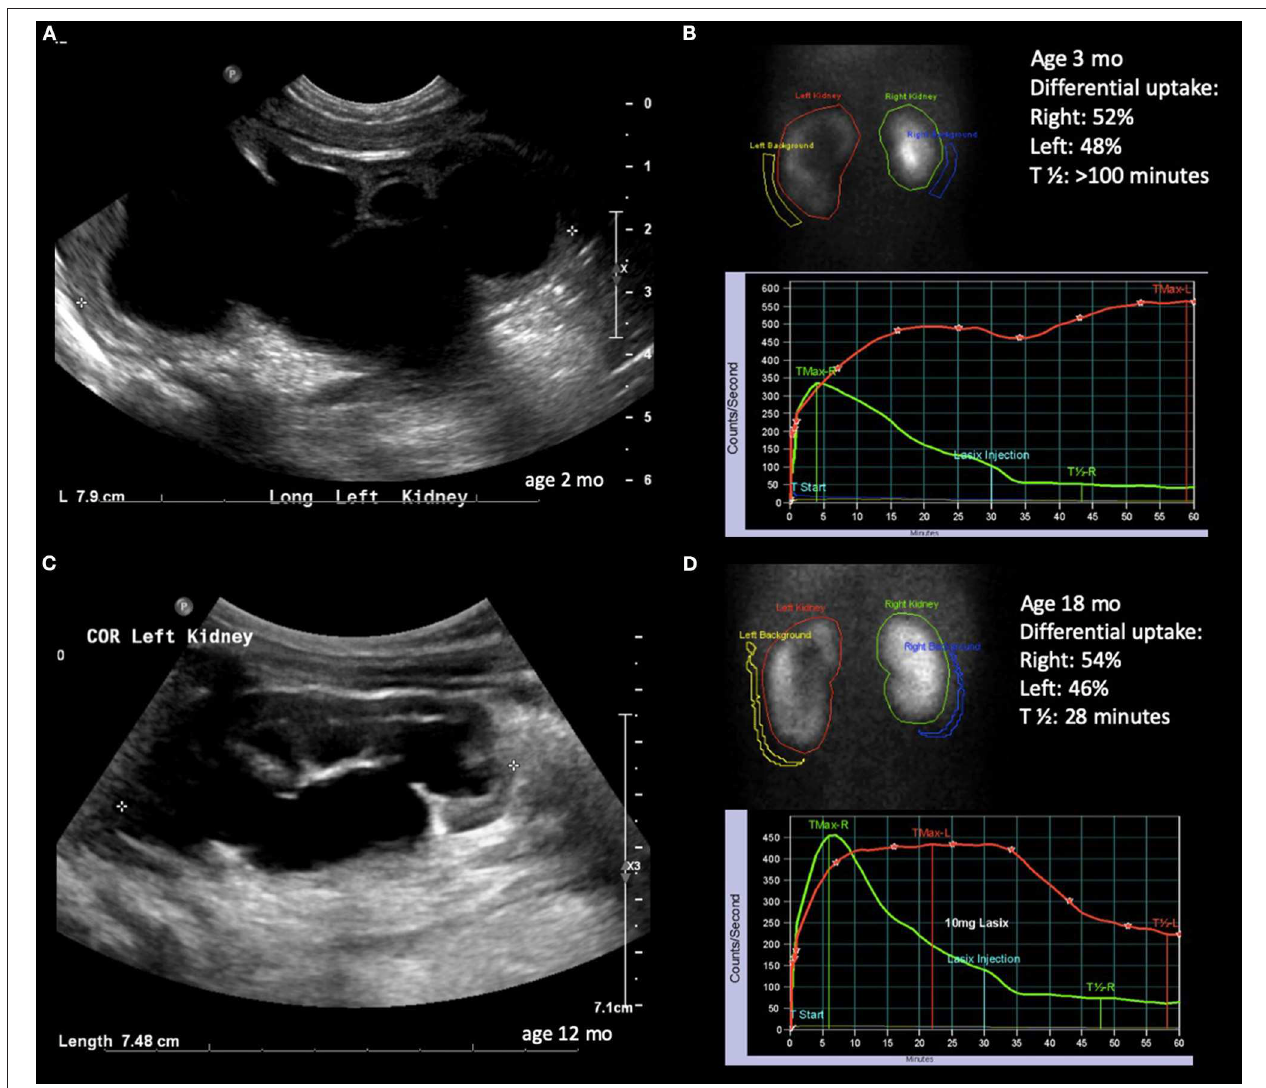
FIGURE 3 | Radiological history of an infant with severe hydronephrosis secondary to UPJ obstruction and biphasic diuretic curve. (A) Ultrasound confirming SFU grade 4 hydronephrosis at 2 months of age. (B) Diuretic renogram showing symmetrical uptake with biphasic washout curve. (C) Ultrasound at 12 months of age showing slightly improving but still SFU grade 4 hydronephrosis. (D) Improved washout curve on diuretic renogram, but still with delayed